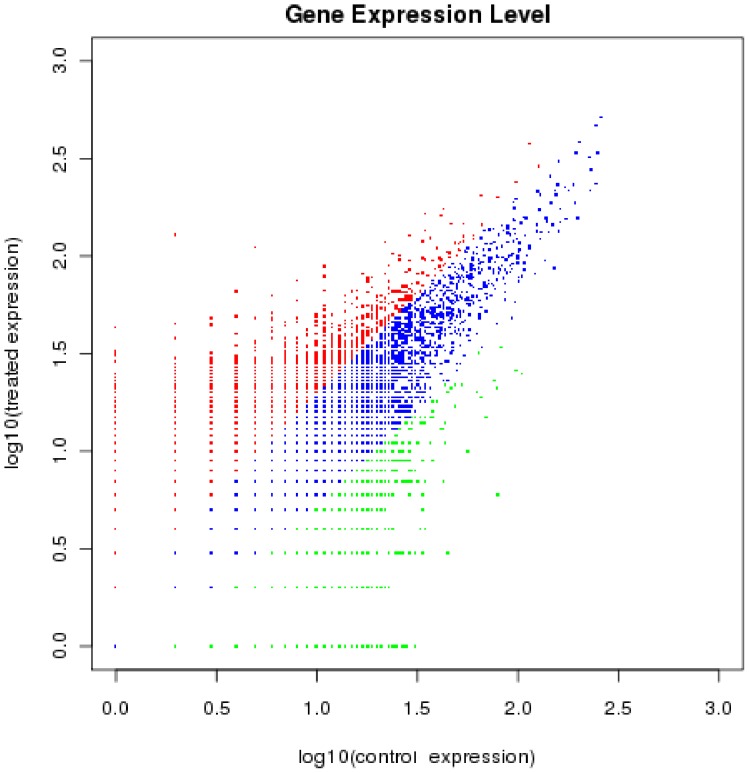
Scatter plot, the different expressed genes of the two samples.The blue dots that differed by less than two fold between the two libraries, defined “no difference in expression”, the red dots (50514) and green dots (26222) represented the up-regulated and down-regulated expressed genes.